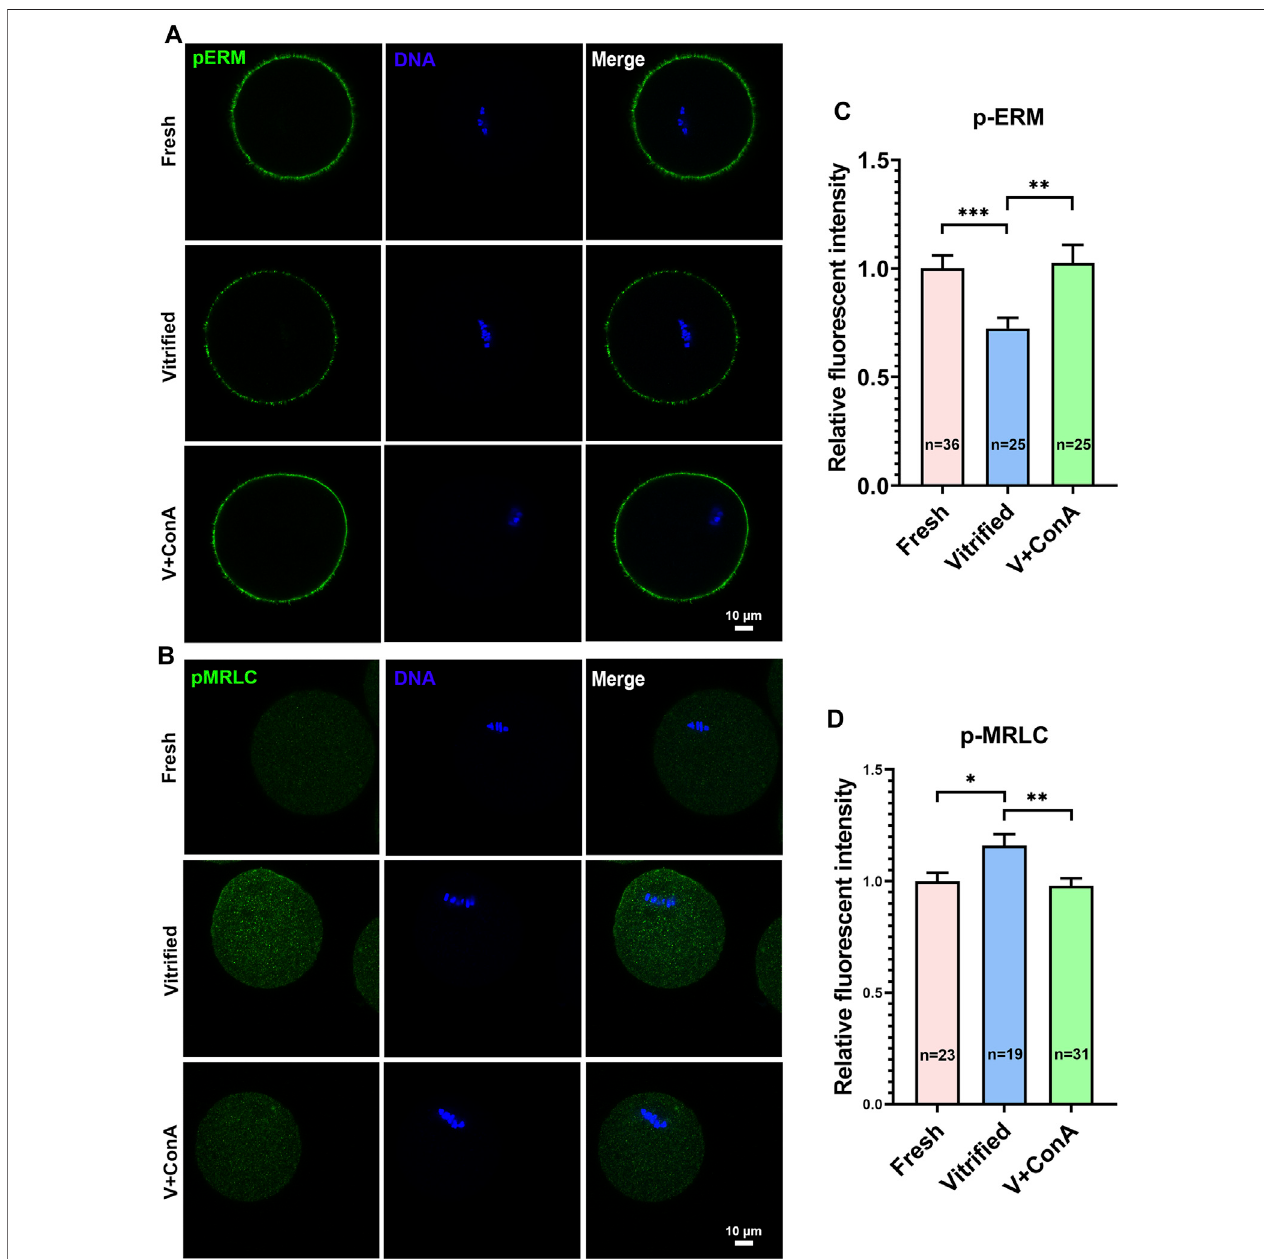
FIGURE4| ConAeffectivelyelevated cortical tension invitri fi ed oocytes. (A) Representative images ofpERM stainingin metaphase I(GV +8 h) oocytes.Scale bar = 10 μ m. (B) Representative images of pMRLC staining in metaphase I oocytes. Scale bar = 10 μ m. (C) Quanti fi cation of the relative pERM fl uorescence intensity in the fresh( n =36), vitri fi ed( n = 25)and V+ ConA( n =25) groups. (D) Quanti fi cation oftherelative cytoplasmicpMRLC fl uorescenceintensityin thefresh ( n =23), vitri fi ed ( n = 19) andV+ConA( n =31)groups. Datawerepresentedasmeanpercentage (mean±SEM)ofatleastthreeindependentexperiments.* p < 0.05, ** p < 0.01,*** p <